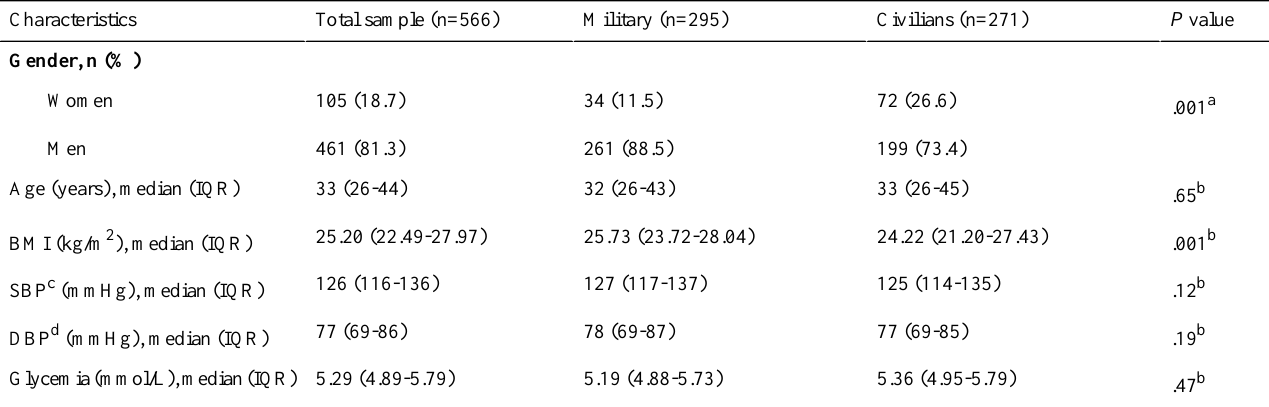
Table 1. Demographic characteristics and clinical parameters of the sample